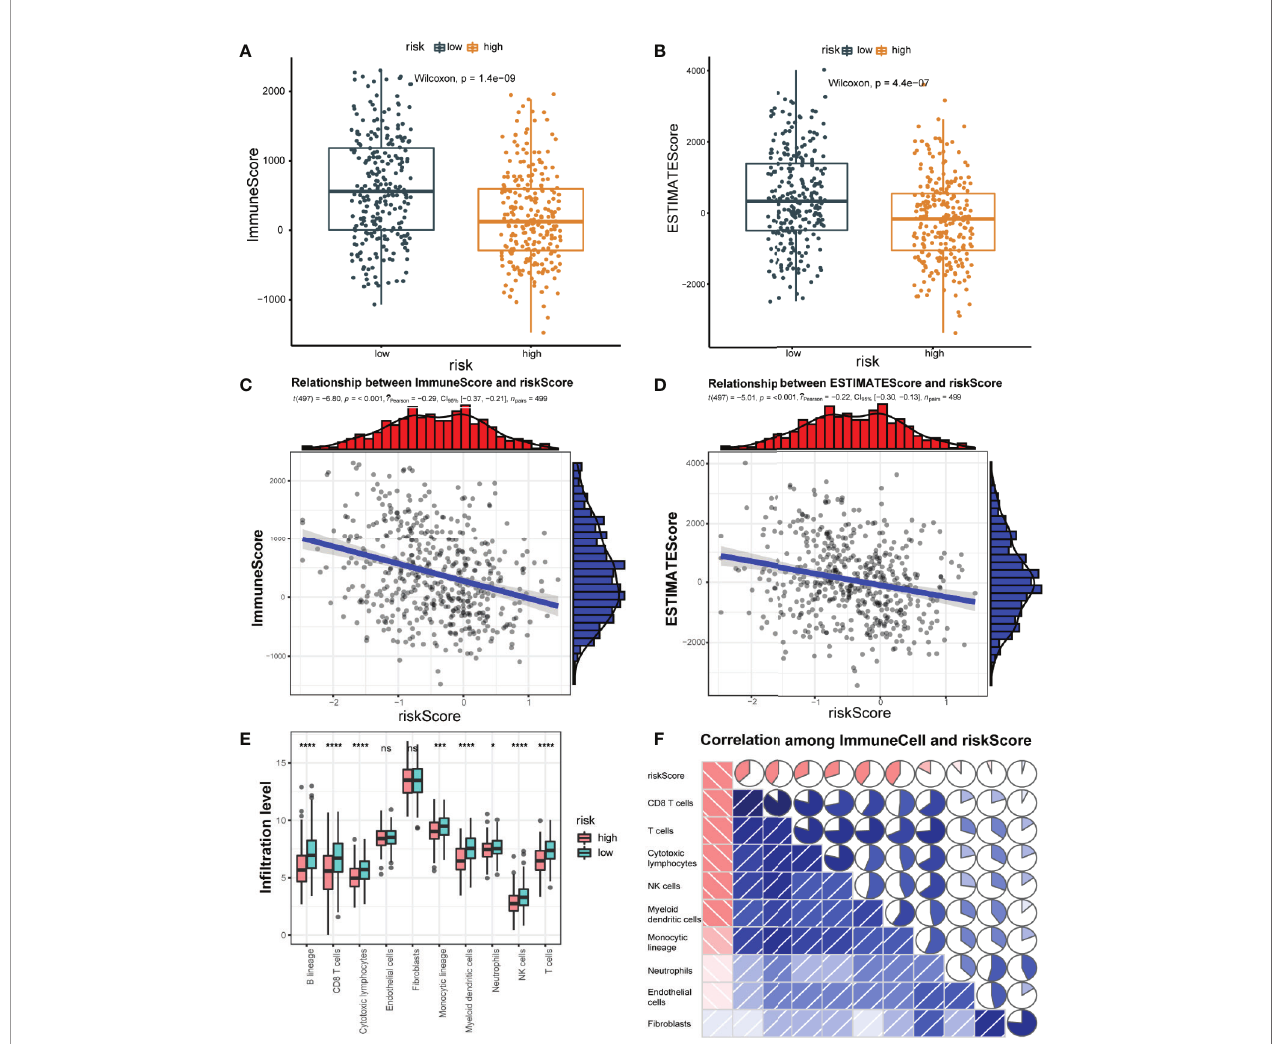
FIGURE 5 | Correlation of 21 IRLPs features with immune cell in fi ltration and immune scores. (A) The Wilcoxon rank-sum test was used to compare differences in immune scores between low- and high-risk groups. (P < 0.001) (B) The Wilcoxon rank-sum test was used to compare differences in ESTIMATE scores between low- and high-risk groups. (P < 0.001) (C) Spearman ’ s correlation coef fi cients were computed to investigate the potential relationship between risk score and immune scores. (D) Spearman ’ s correlation coef fi cients were computed to investigate the potential relationship between risk score and ESTIMATE scores. (E) The Wilcoxon rank-sum test compared the absolute abundance scores of 8 immune cells and 2 stromal cells populations in two groups of patients. (F) Spearman ’ s correlation coef fi cients were computed to investigate the potential relationship between absolute abundance scores of immune cells and stromal cells and risk score. The area of fan represents the degree of correlation (Red represents a negative correlation and blue represents a positive correlation). ns, no signi fi